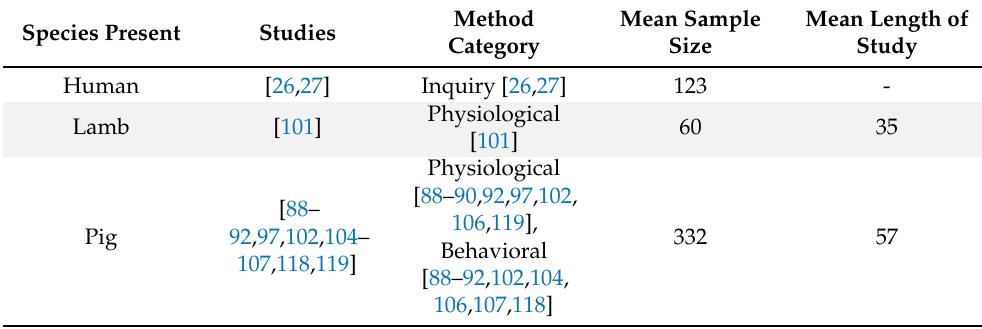
Table 2. Species and measurements break down for farm animals. The mean study length column represents the average time (in days) of study procedures. Shading added to aid readability. Species Present Studies